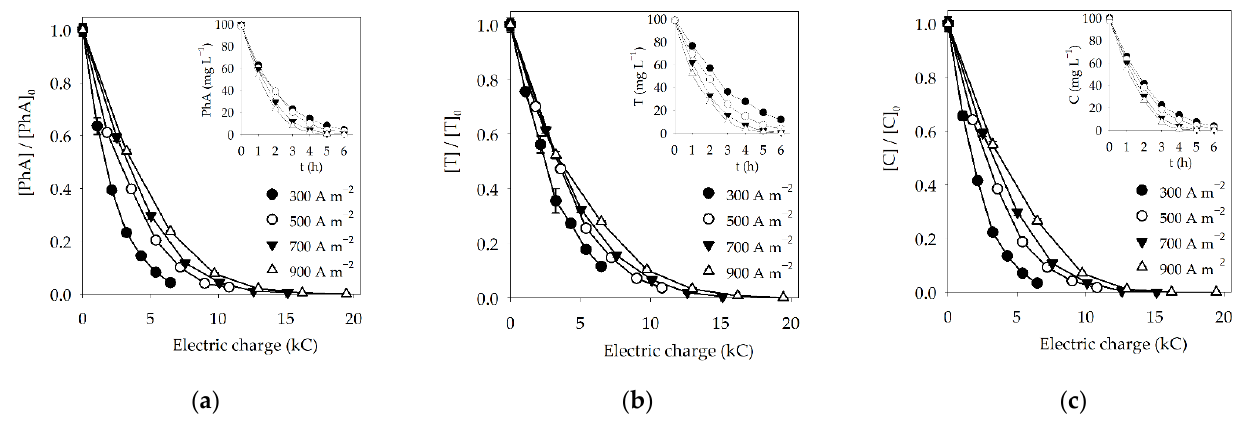
Figure 3. Variation with applied charge and time (insets) of ( a ) phthalic acid, ( b ) tyrosol, and ( c ) catechin concentrations for the EO experiments performed with spiked winery wastewater at different applied current densities.